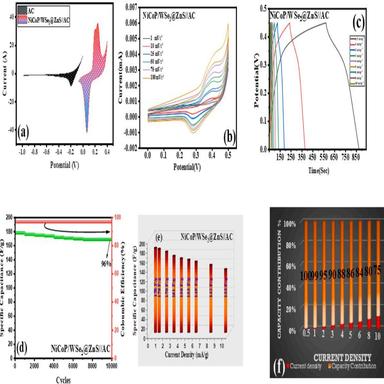
Electrochemical performance of the as-fabricated ASC device. (a) CV curves of NiCoP/WSe2@ZnS//AC and AC (b) CV curve of NiCoP/WSe2@ZnS//AC (c) GCD curves of NiCoP/WSe2@ZnS//AC (d) cyclic performance and Coulombic efficiency of NiCoP/WSe2@ZnS//AC (e) Specific capacitance and current density of NiCoP/WSe2@ZnS//AC (f) current density Vs Capacity contribution.